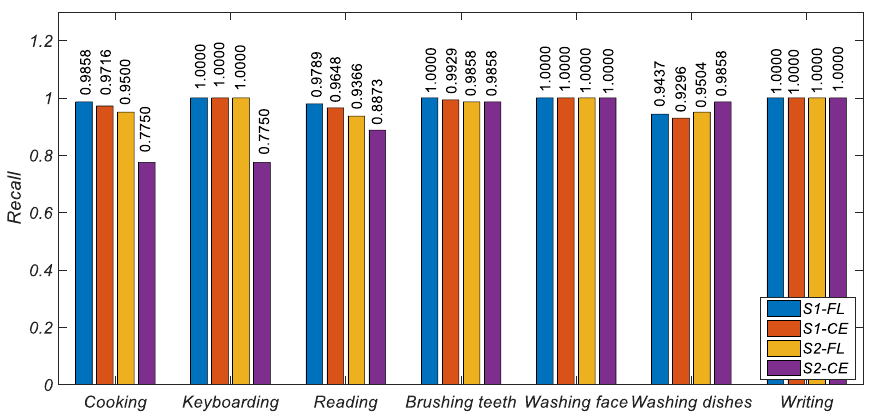
Figure 7. The recall comparison of HAR-CE and HAR-FL in each class.